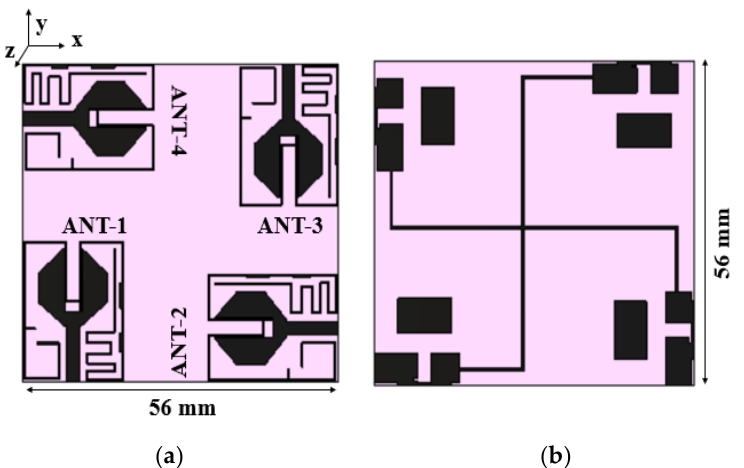
Figure 9. Layout of the proposed MIMO antenna with a common ground plane: ( a ) front view, ( b ) rear view.